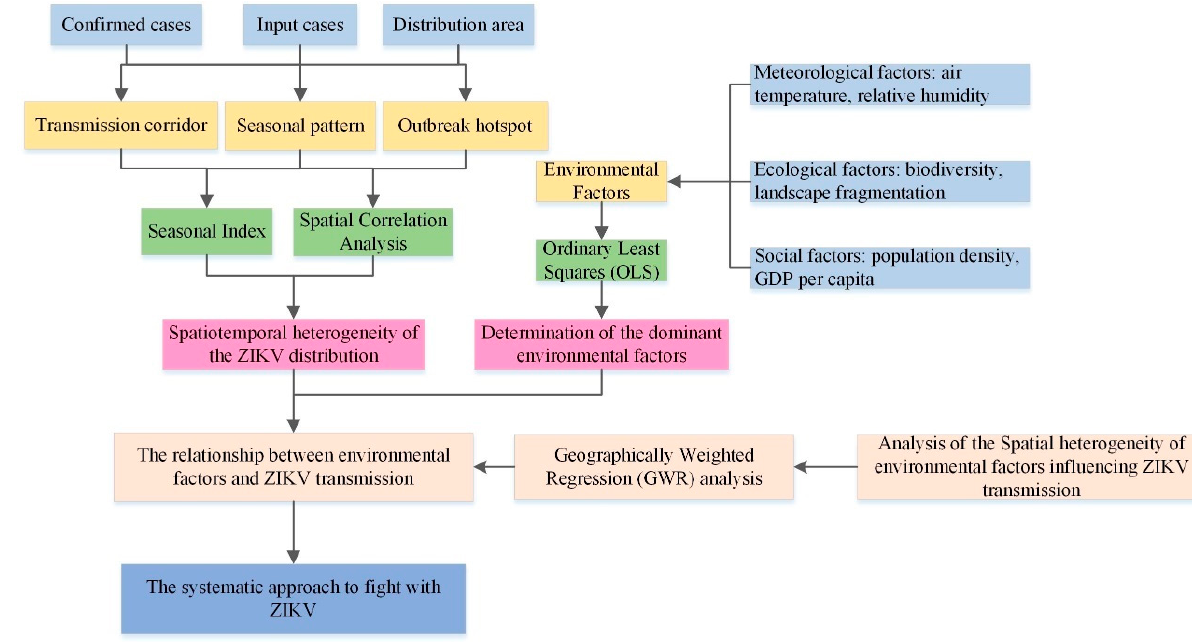
Figure 4. The research flowchart.